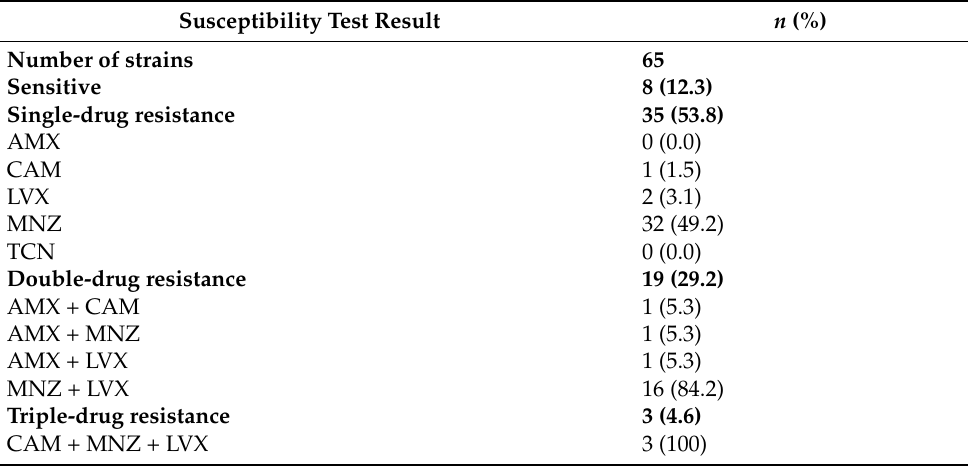
Table 2. Prevalence of resistance toward single and multiple drugs in